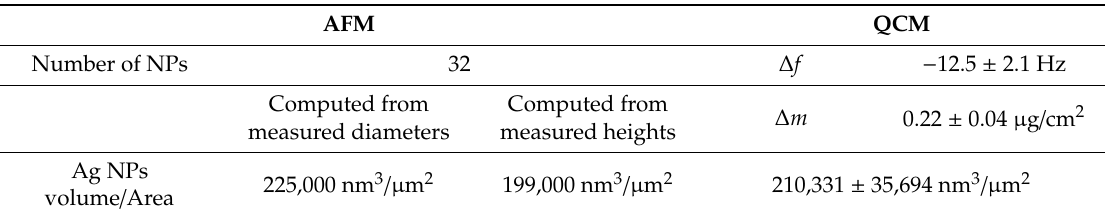
Table 1. Atomic force microscopy (AFM) and quartz crystal microbalance (QCM) values for the calculation of Ag nanoparticles